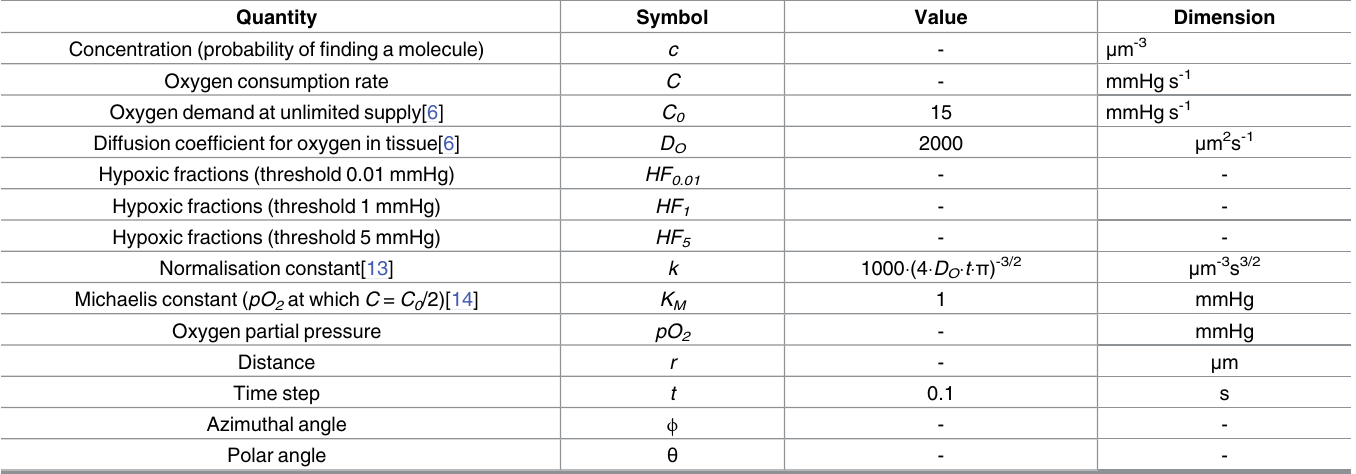
Table 1. Symbols and dimensions of quantities and parameter setting used in the